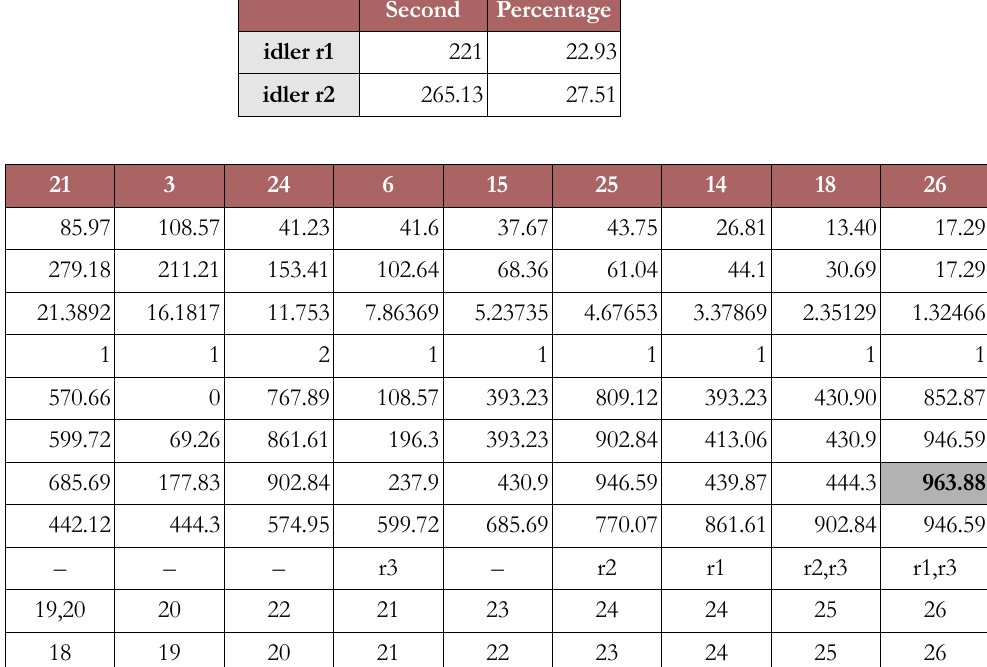
Table 15. TIMRES Scheduling, Rmax = 2, n(r) = 3 (Scenario